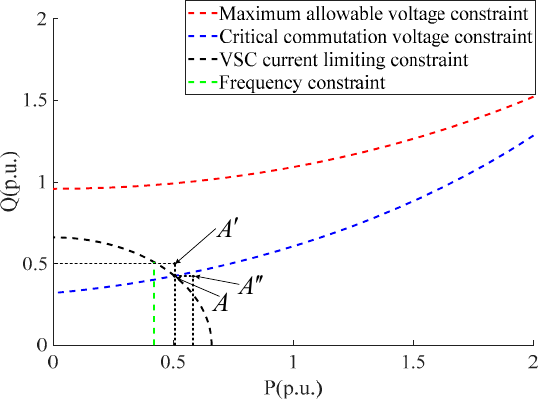
Figure 8. Controllable operation region of the hybrid dual ‐ infeed HVDC system.